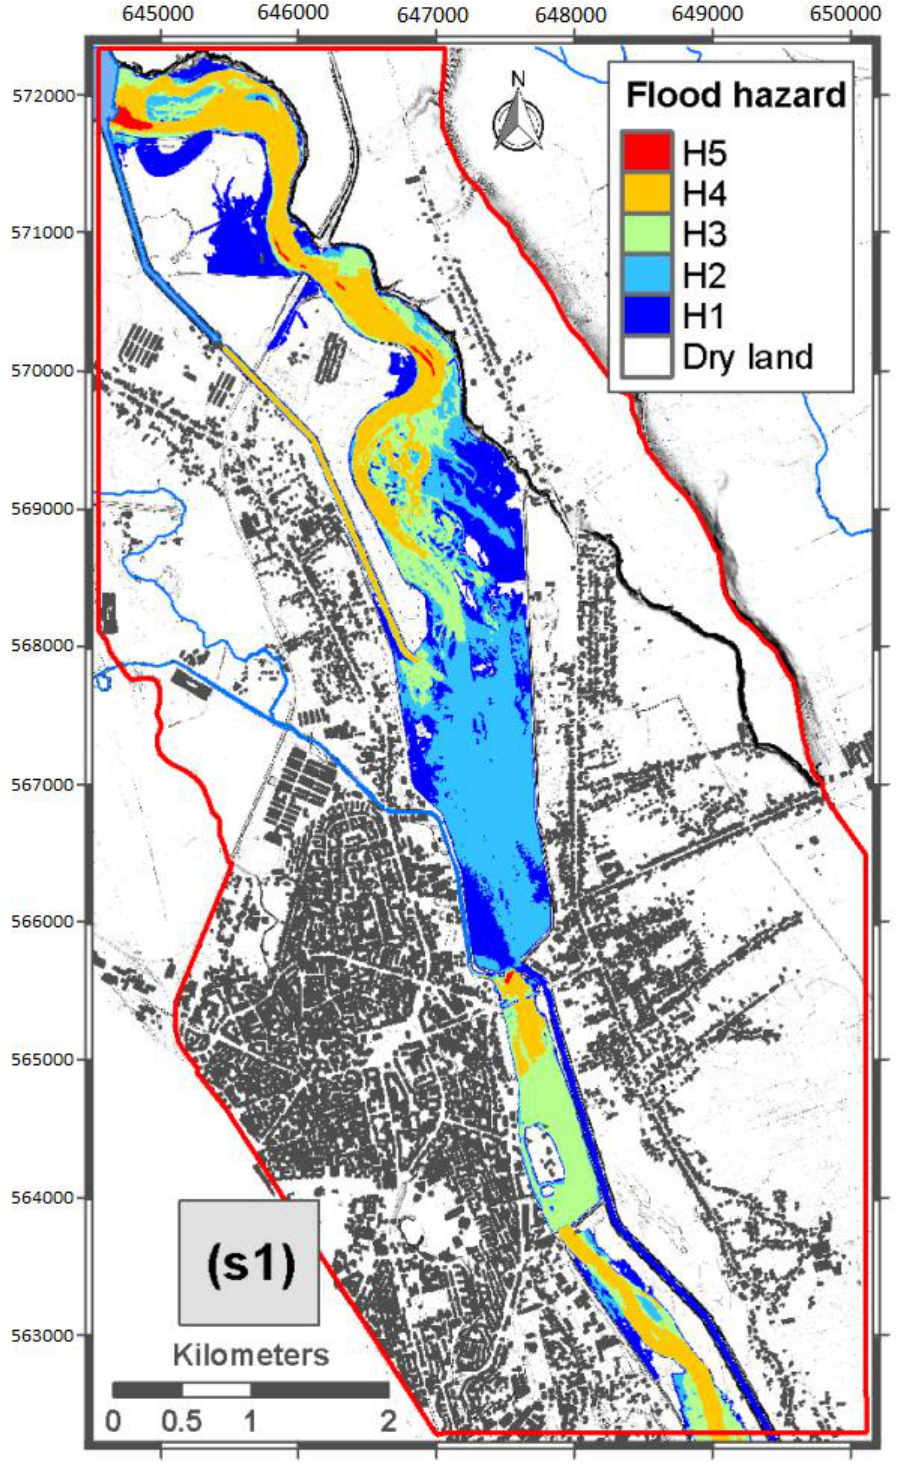
Figure 5. Flood hazard map based on flood depth classification according to the Ministry of Land Infrastructure and Transport (MLIT)